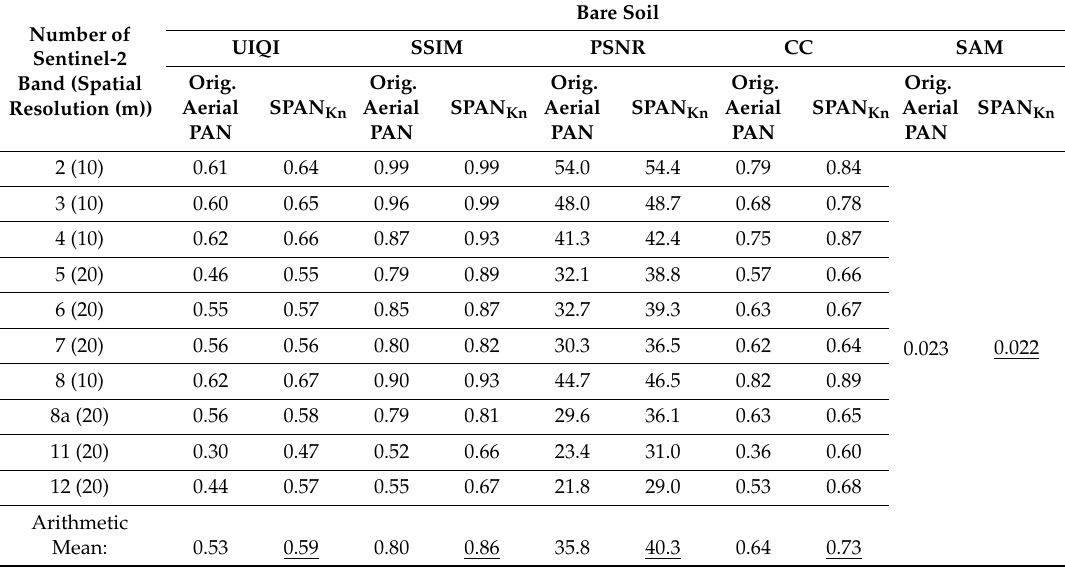
Table 4. Spectral quality values for the bare soil sample (the best results are underlined).